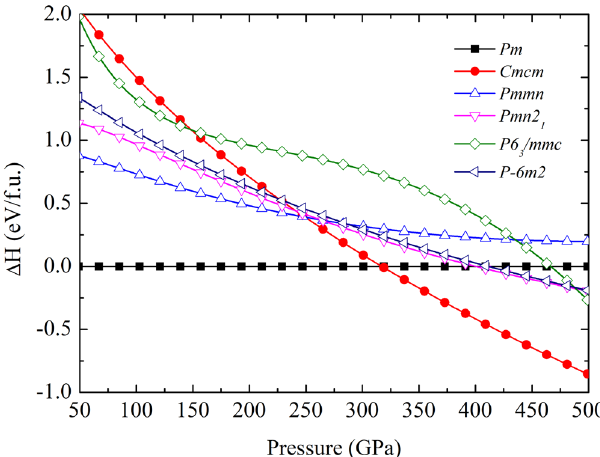
Figure 1. The relative enthalpy as a function of pressure ranging from 50 GPa to 500 GPa of CaCH 5